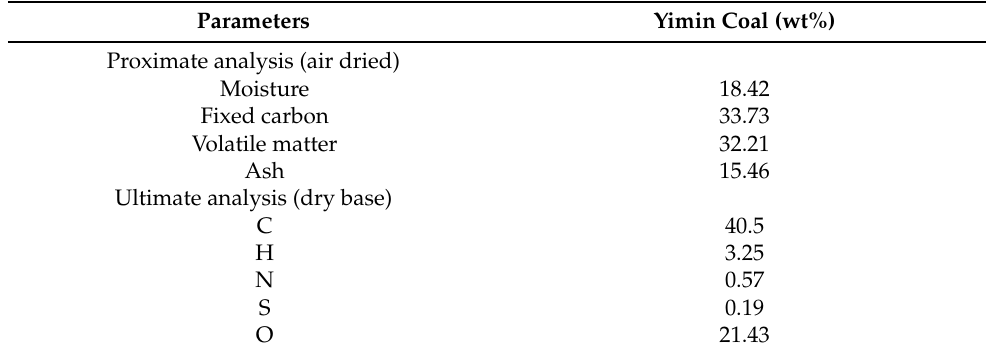
Table 1. Analysis of the Yimin coal.